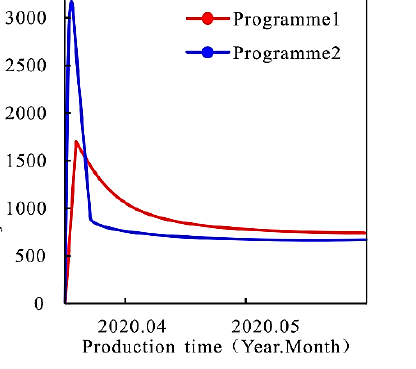
Figure 10. Relationship between injection speed and time.